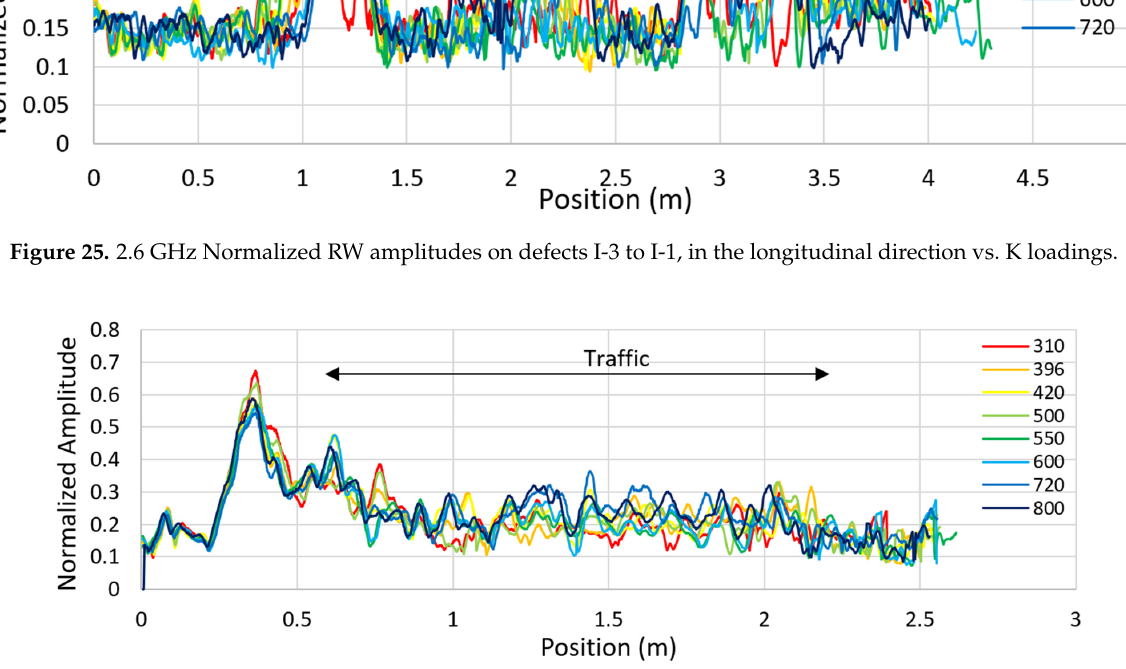
Figure 26. 2.6 GHz Normalized RW amplitudes on sand (I-1), in the transversal direction vs. K loadings.